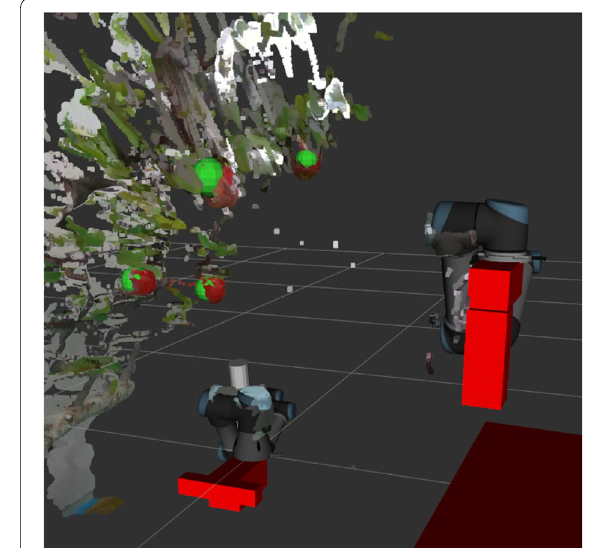
Fig. 6 Example of robot and fruits